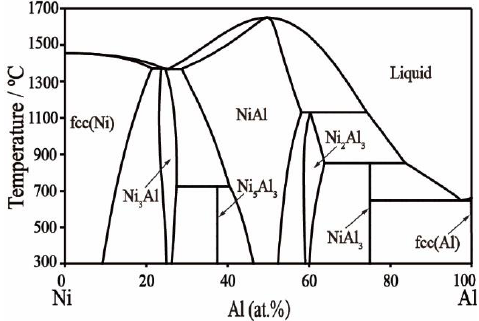
Figure 1. Calculated Ni – Al phase diagram.